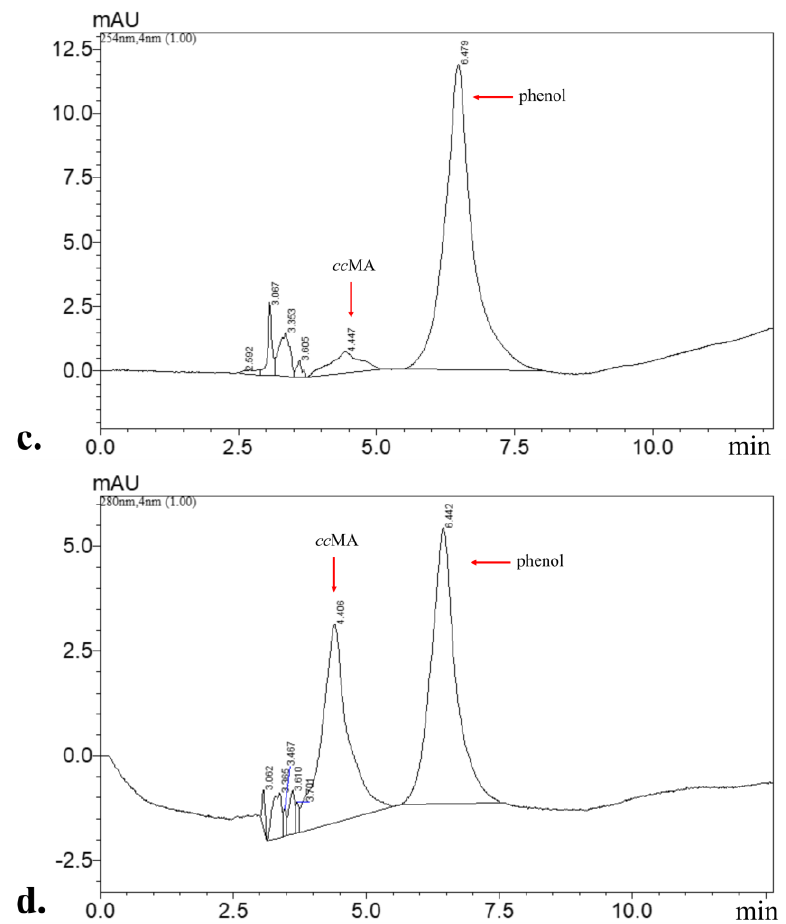
Figure 4. The profile of phenol concentration changes in free Sphe3 cell culture at different timepoints. Error bars indicate standard deviation of three measurements ( a ). HPLC analysis of sample taken from Sphe3 culture in phenol at 2 h ( b ). HPLC analysis of sample taken from Sphe3 culture in phenol at 12 h ( c ) and at 24 h ( d ). Red arrows indicate cc MA, catechol, and phenol.